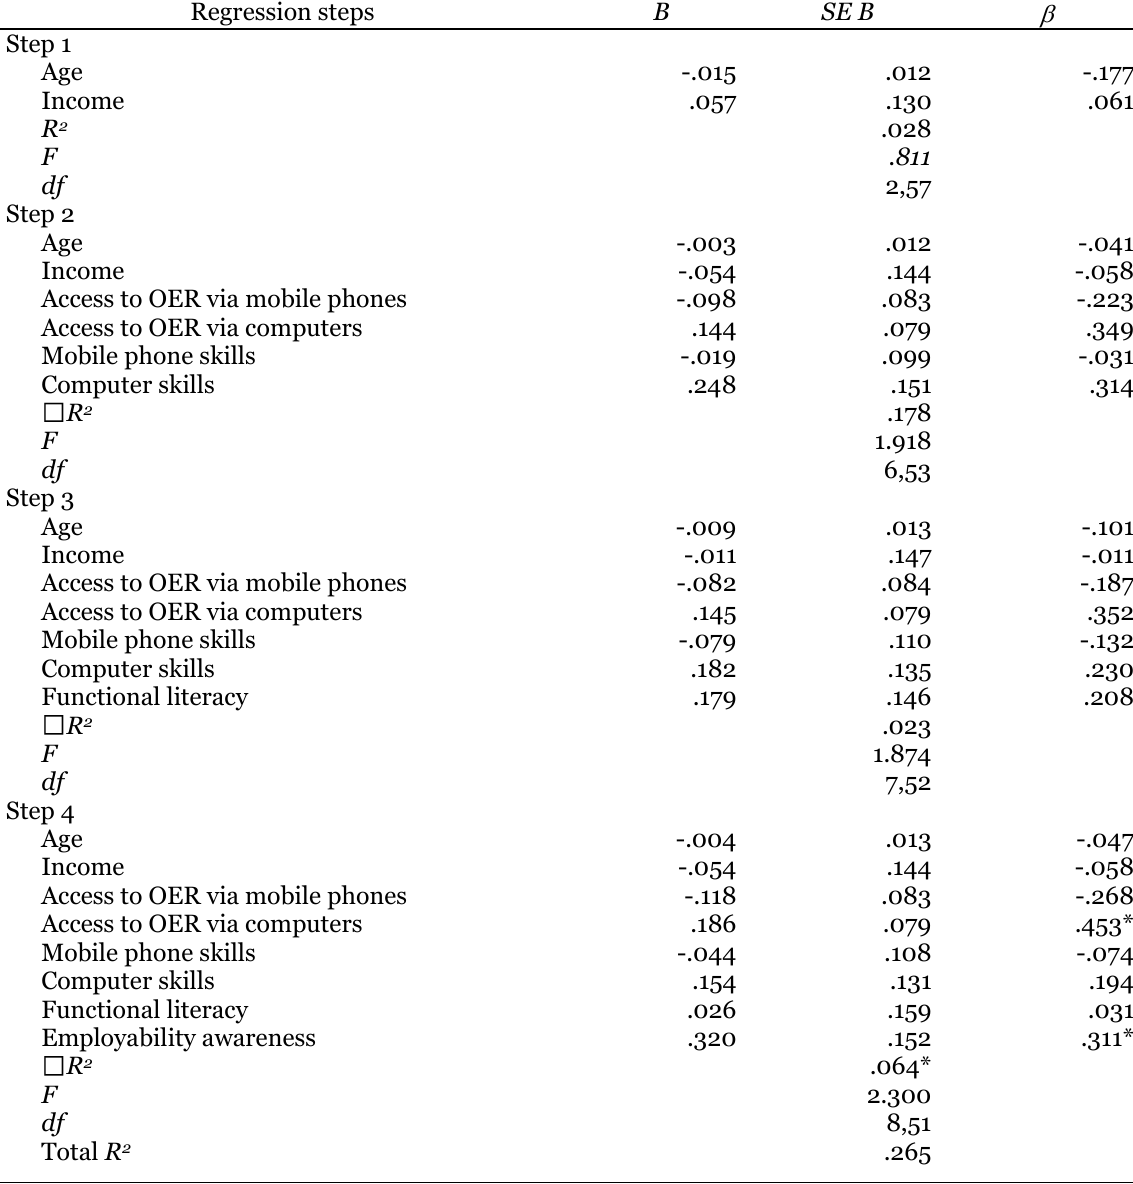
Predictors of Perceived